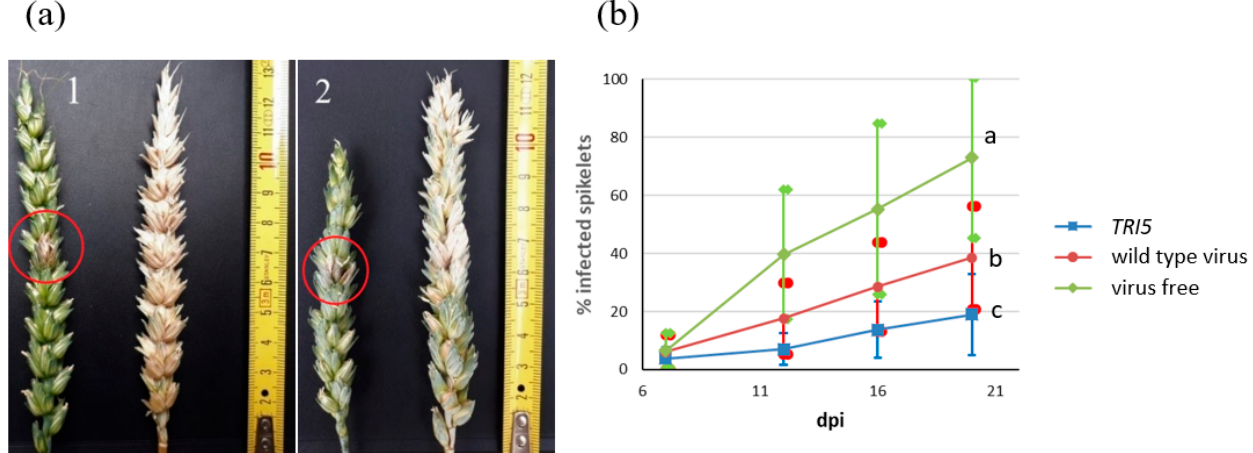
Figure 3. ( a ) FHB spread on wheat head at 20 dpi. 1: variety Zlata, 2: variety Ivolga. On the left: plant infected with the TRI5 construct, on the right: negative control. The red cycle indicates the spikelet that was inoculated with F. culmorum . ( b ) Dynamics of spikelet infection. The graph shows the percentage of infected spikelets at 7, 12, 16, and 20 dpi, presenting the means and standard deviations of two independent experiments with at least six replicates each. Virus free plants were mock inoculated with water, wild type virus plants with BSMV RNAs α + β + γ , and TRI5 plants with BSMV RNAs α + β + γ -TRI5; for more details see Section 2.7. Letters to the right of the graphs indicate statistical significance; p -value ≤ 0.05.